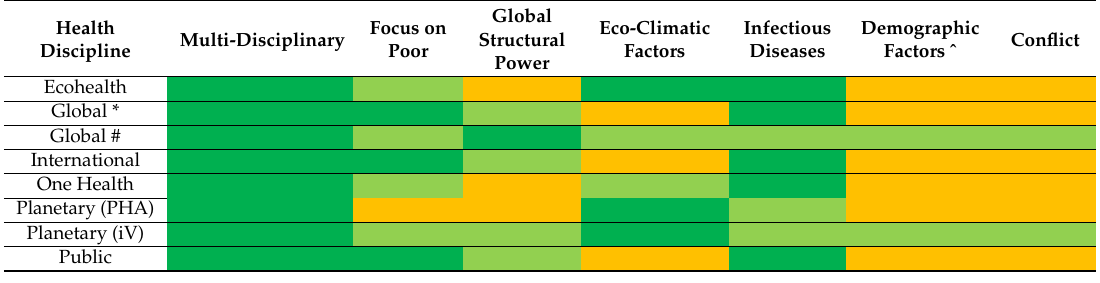
Table 2. Prominent themes of ecohealth, international health, global health, One Health, planetary health (two flavors) and public health. Key * most common definition; # less common definition; ˆ not just total size but growth rate as a determinant of health outcomes; PHA = Planetary Health Alliance; iV = inVIVO; dark green = strong, light green = moderate; orange =